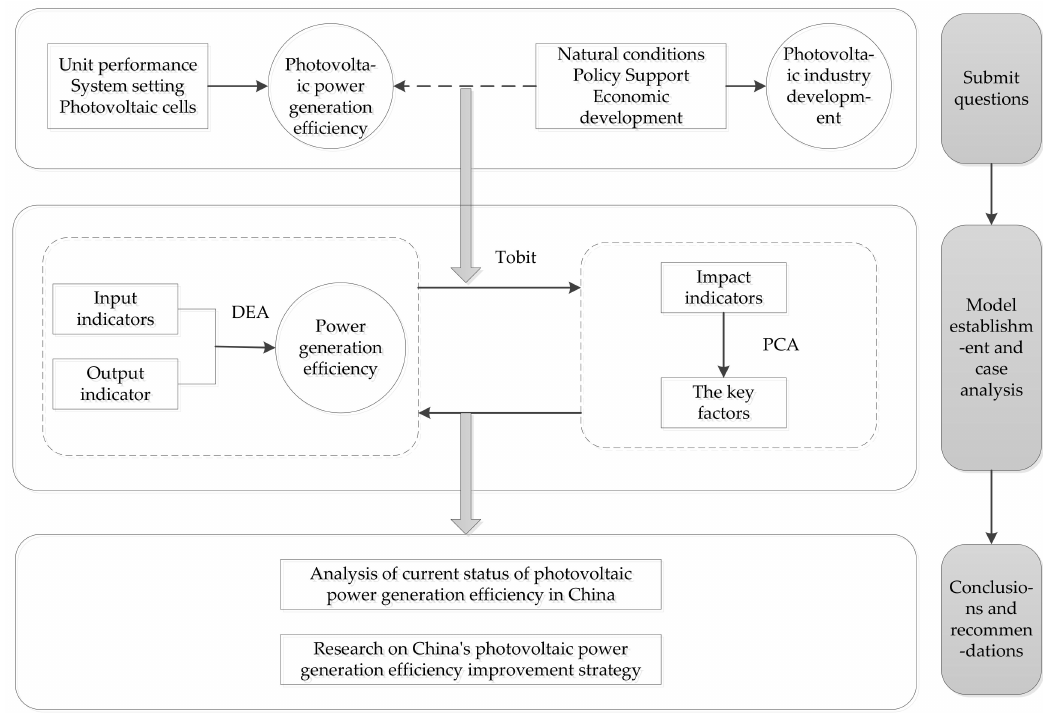
Figure 3. Research